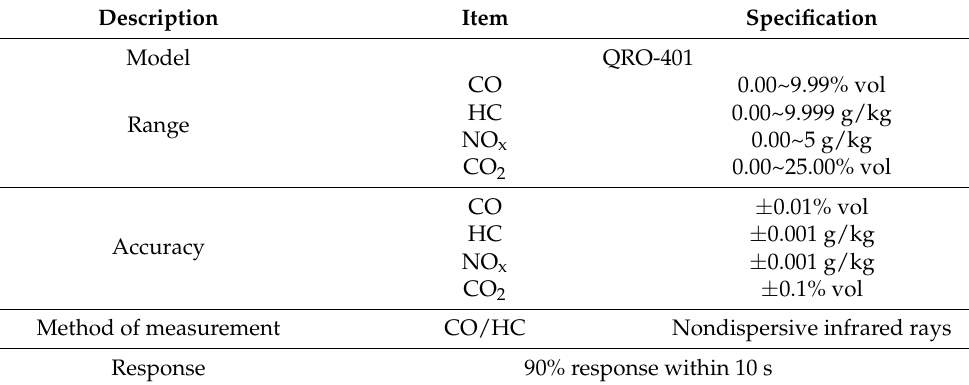
Table 4. Specifications of emission measurement equipment.